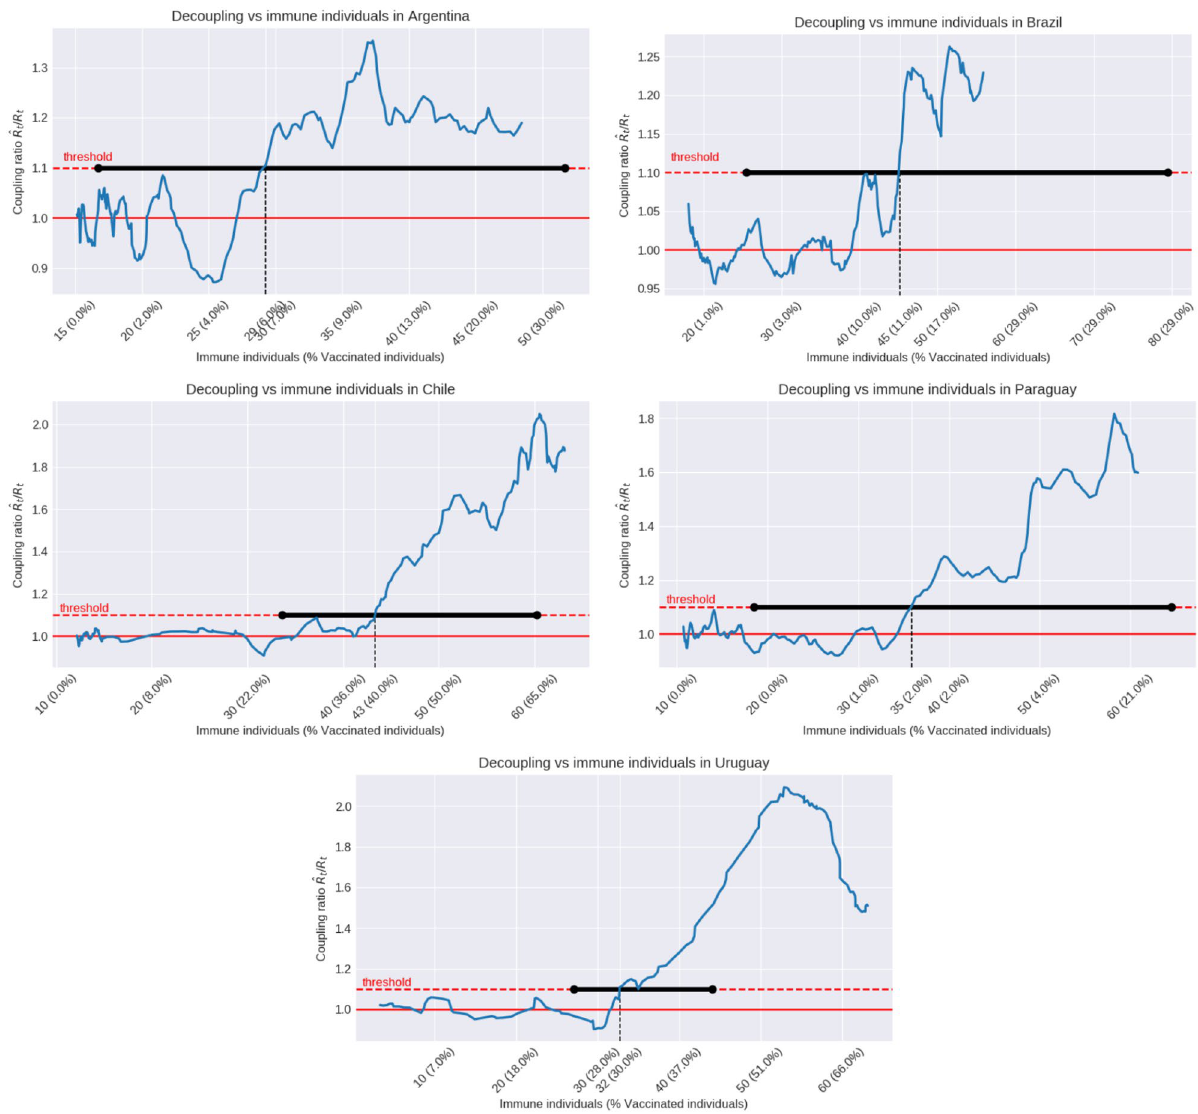
ˆ R Figure 2. Coupling ratio t / R t plotted with respect to the estimated percentage of immune population. During the first months of 2021 the coupling ratio varies around 1, which corresponds to the periods where the R t ˆ R and t are in concordance in Fig. 1. Immune population includes immunity achieved by vaccination (taking into account its effectiveness) and natural infection (see “Estimation of the IFR and immune population” section). The percentage of people fully vaccinated is described as well. The coupling ratio crosses the threshold (decoupling point) at percentages of immune population that varies along the five countries from 29% in Argentina to 33% in Uruguay, 37% in Paraguay, 43% in Chile and 45% in Brazil. Confidence intervals are shown in horizontal black lines. They inherit the large uncertainty in the IFR estimation (see Table